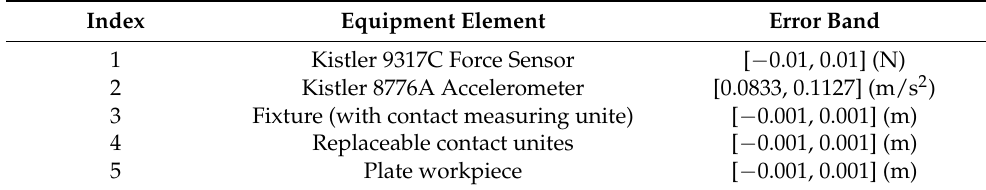
Table 6. The error band of each element in the modified experiment’s